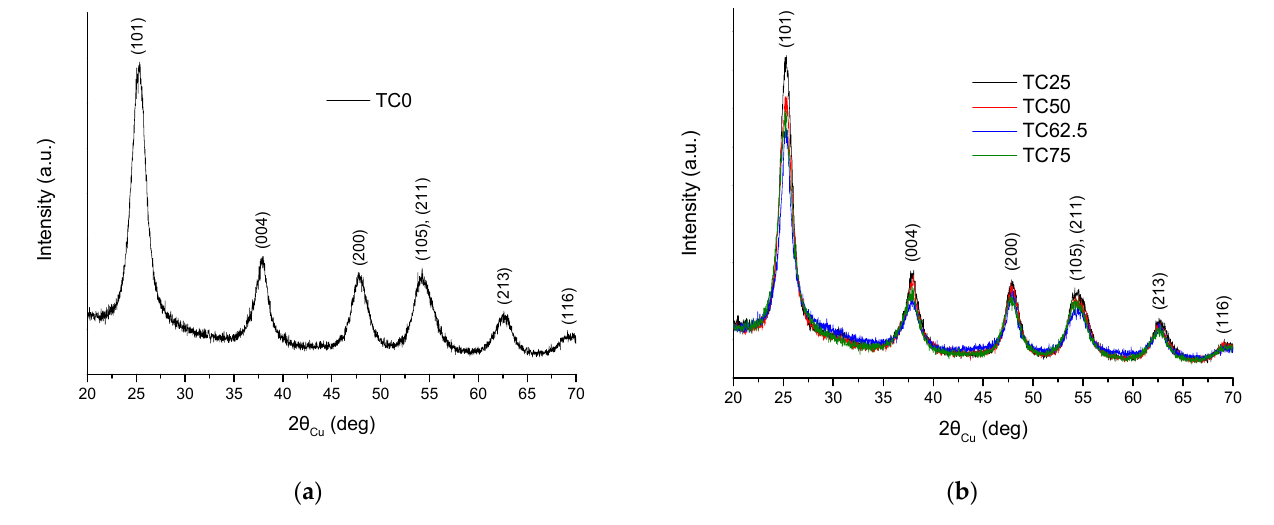
Figure 3. X-ray diffraction patterns of ( a ) TiO 2 (TC0) and ( b ) TiO 2 with different C-dot loading